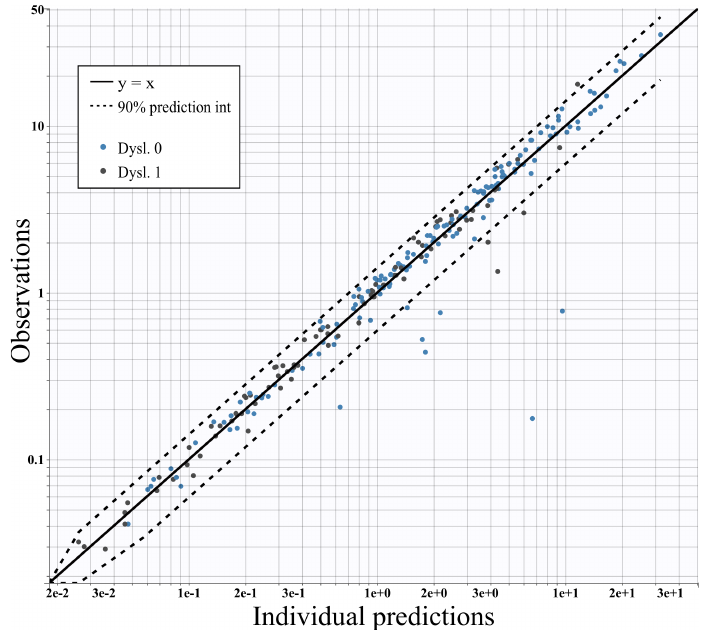
Figure 8. Observations vs individual predictions for the model taking into account the dyslipidemic covariate (i.e., model 2 in Table